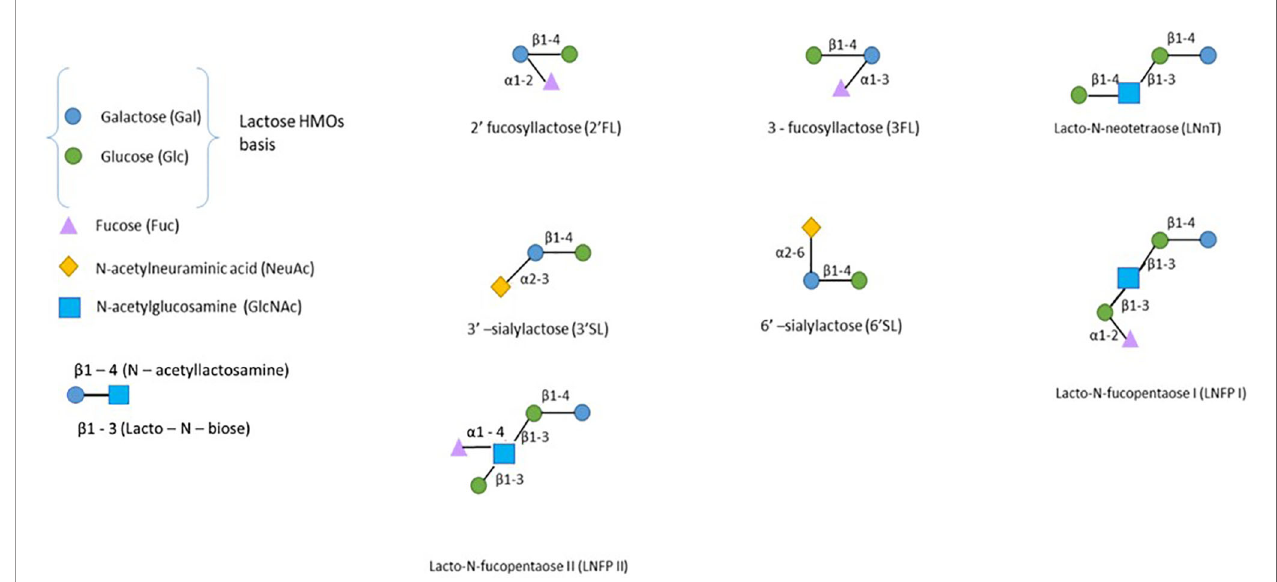
FIGURE 2 | The structure of human milk oligosaccharides. HMOs can be classi fi ed into neutral fucosylated HMOs (2 ’ -FL, 3FL, and LNFPI-II), neutral HMOs (LNnT) and sialylated HMOs (3 ’ SL and 6 ’ SL). Only the most prevalent HMOs are presented here